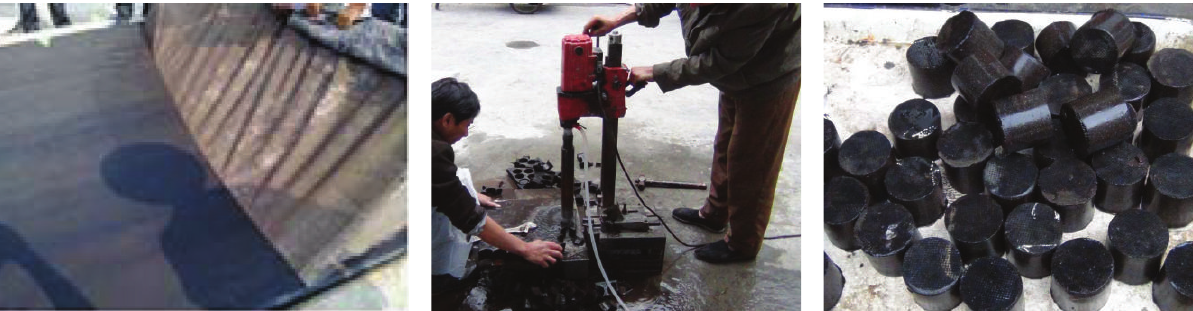
Figure 1: Sampling process and part